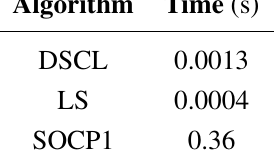
Table 3. The average energy depletion of the considered algorithms for known P